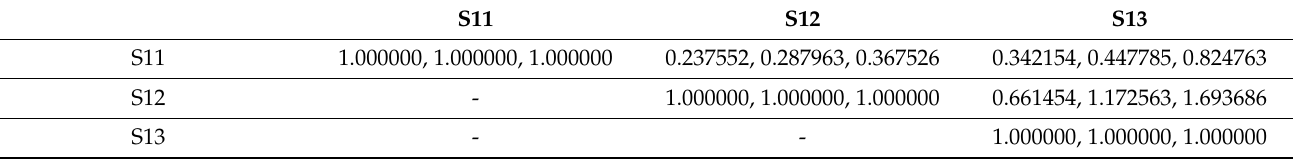
Table 2. The fuzzy-aggregated pairwise comparison matrix at Level 2 for regulatory.